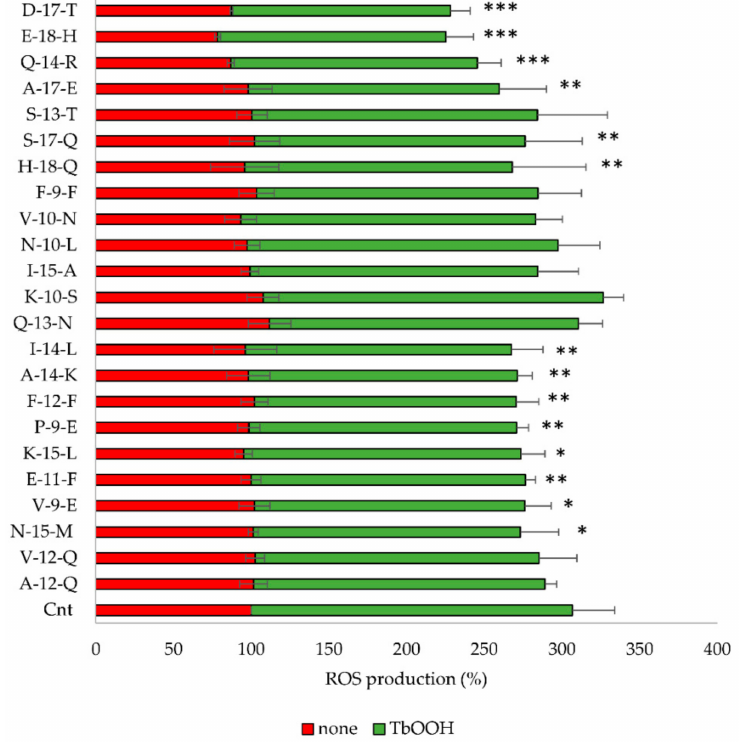
Figure 2. Estimation of reactive oxygen species (ROS) production in Caco-2 cells treated with the indicated peptides (0.05 mg / mL) in the absence (red) or presence (green) of 250 µ M TbOOH. The values at 5000 s were reported and the means of at least three experiments (four replicates for each experiment) were compared with the treated control. (*** p < 0.001, ** p < 0.01, * p <